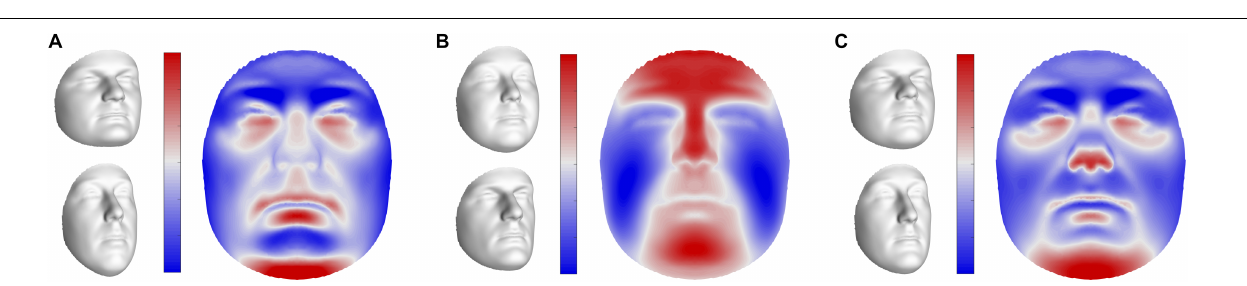
FIGURE 5 | Global shape variations in offspring. Visualizations of the first three extracted latent variables at the global level in sons. Shape variations in daughters and fathers can be found in Supplementary Figure S5 . (A) PLS component 1, (B) PLS component 2, (C) PLS component 3. In gray, illustrations of shape transformation or morph images ( ± 4 standard deviations of the median), representing the direction in shape space encoded by the latent variables. In color, the normal displacement in each quasi-landmark, going from the lower (top) to the upper (bottom) extreme. Blue, inward repression; red, outward